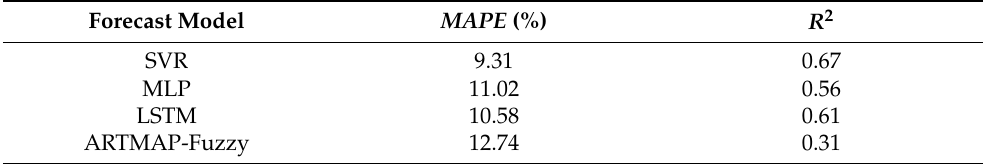
Table 12. MAPE and R 2 for 6-h horizon